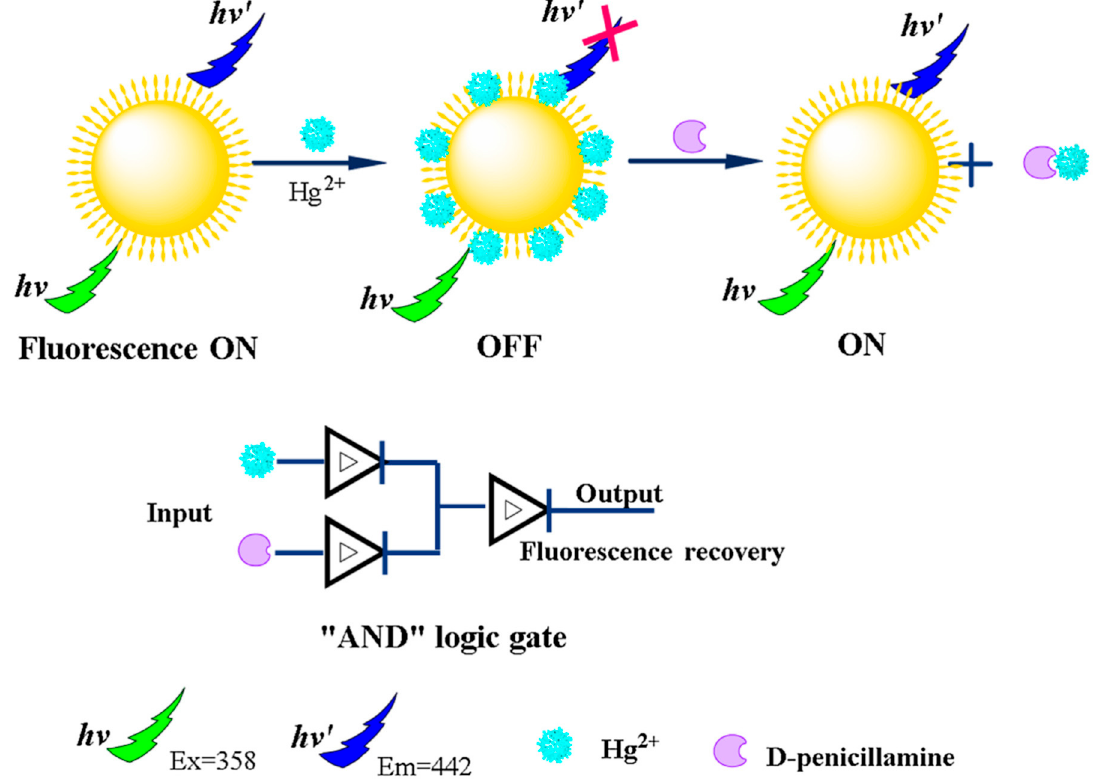
Figure 5. Schematic diagram of D-Penicillamine (D-PA) detection by pristine CDs and its AND logic gate function. Reproduced from ref [65] with permission of Sensors and Actuators, B: Chemical copyright 2016.